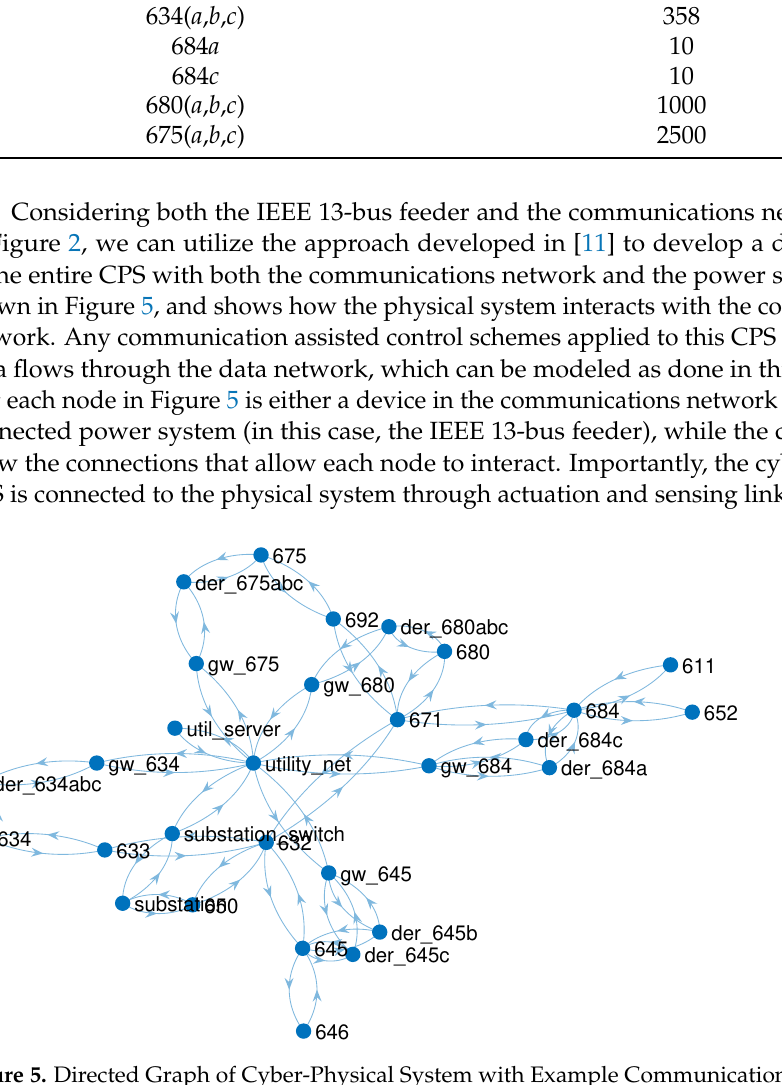
Figure 5. Directed Graph of Cyber-Physical System with Example Communications Network and IEEE 13-bus Test